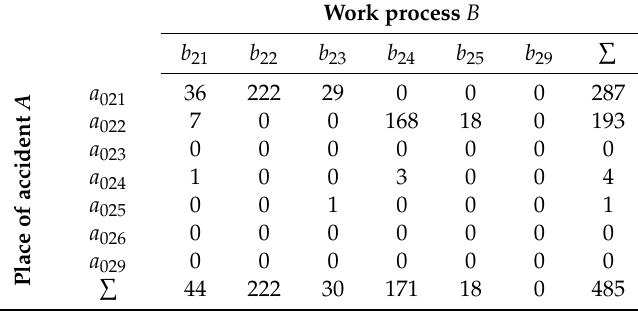
Table 3. Matrix of relationships between the place where the accident occurred and the work